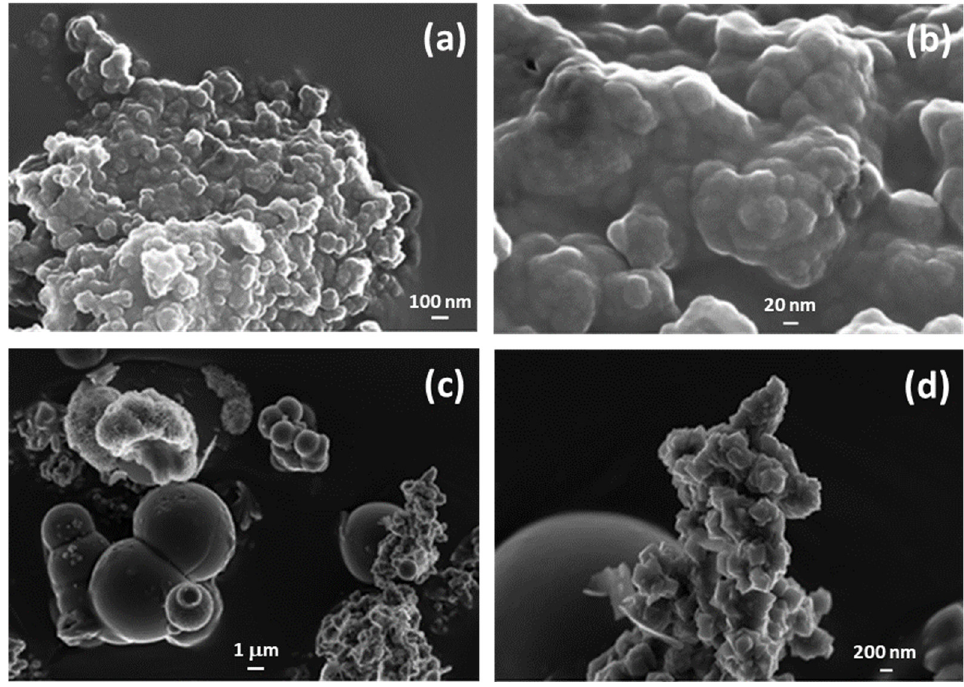
Figure 4. FESEM images for allophane ( a , b ) and for ZnAl-SO 4 LDH ( c , d ) at different levels of mag- nification.